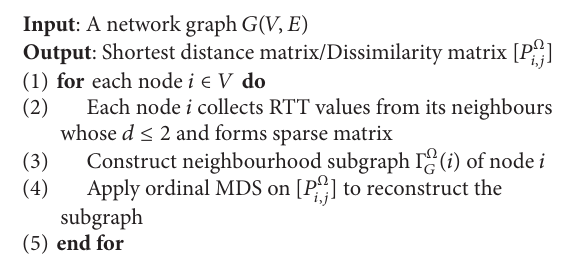
Algorithm 1: Floyd-Warshall shortest distance algorithm for